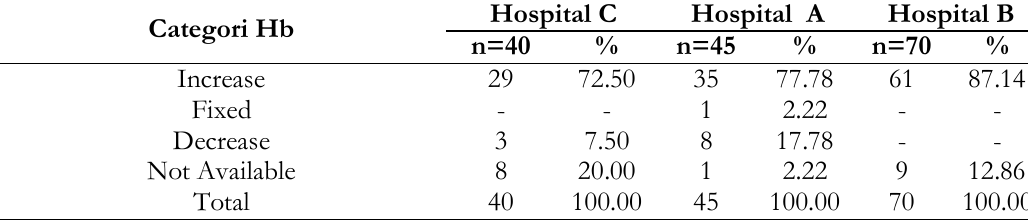
Table II. Patients who experiencing increase in hemoglobin levels.